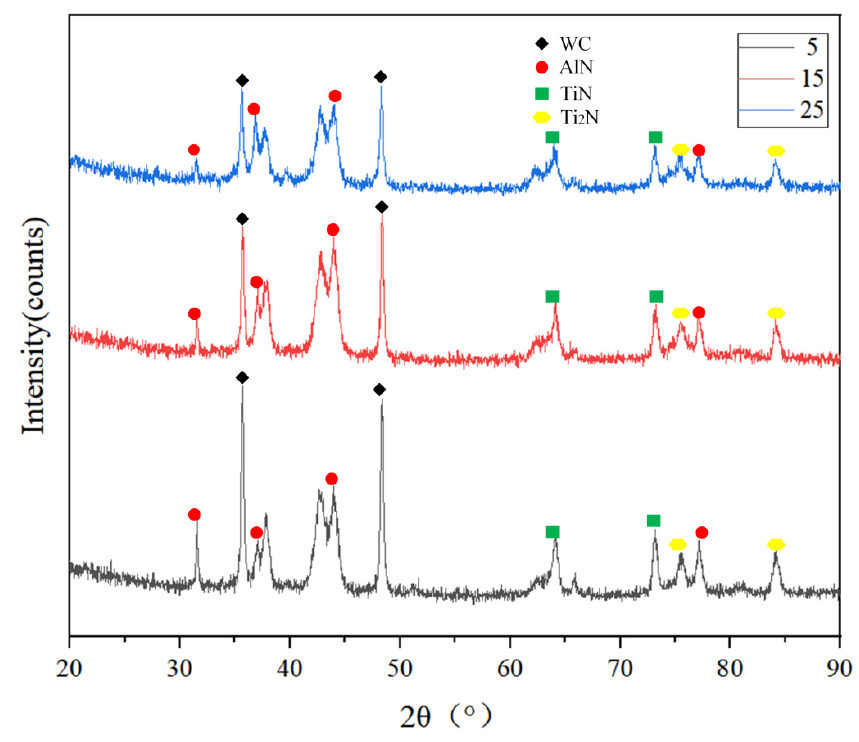
Figure 5. X-ray diffraction pattern of the AlSiTiN Figure 5. X-ray di ff raction pa tt ern of the AlSiTiN coating.